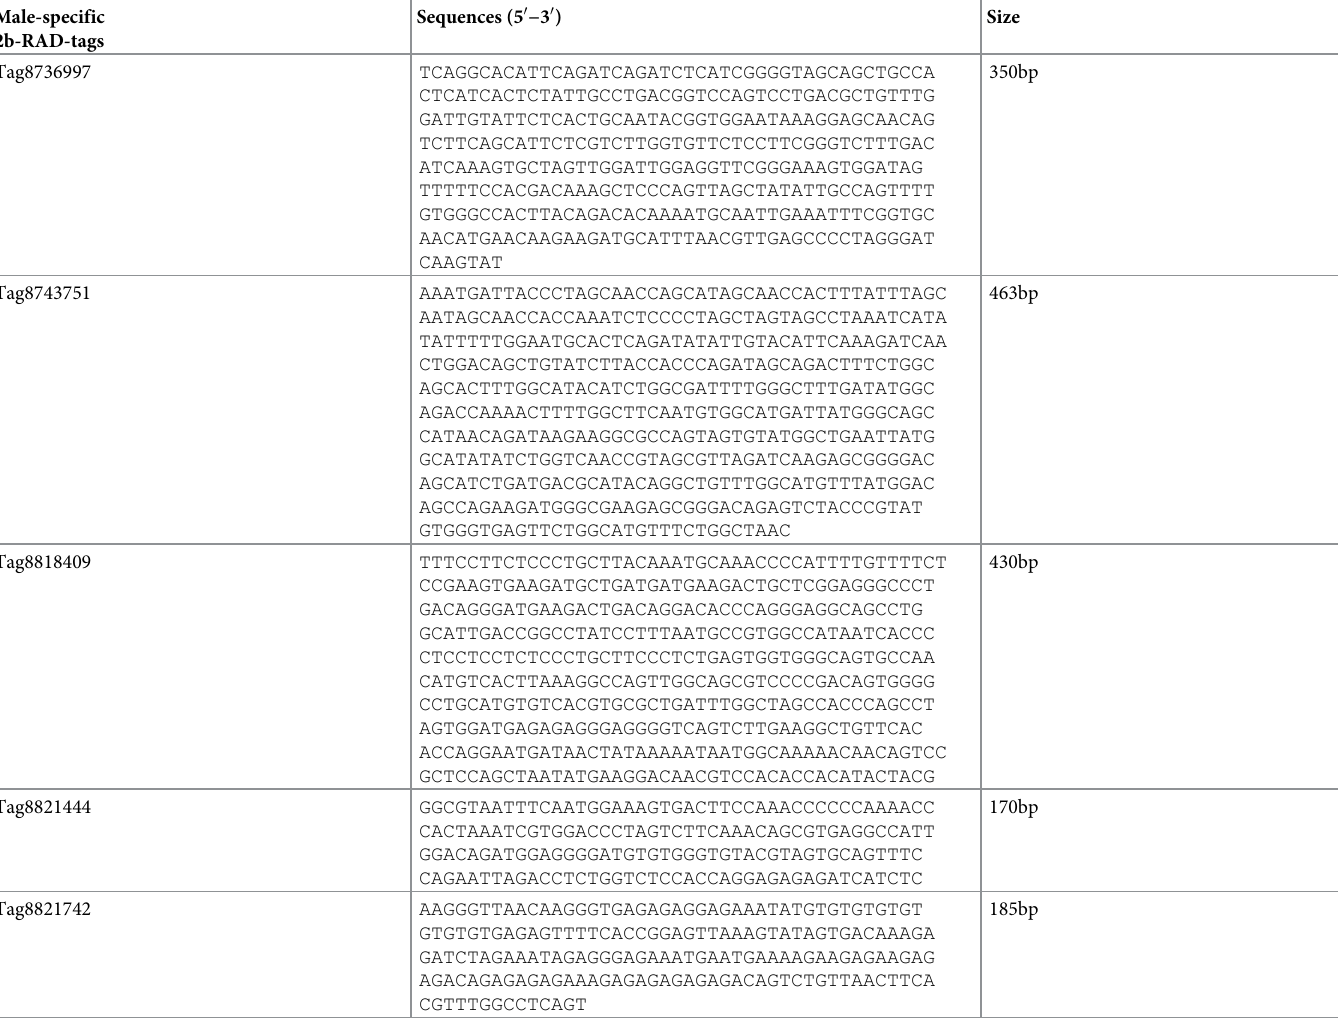
Table 4. Information of the nucleic acid sequence obtained from male Alosa sapidissima (JAHTKL010000000). Male-specific 2b-RAD-tags